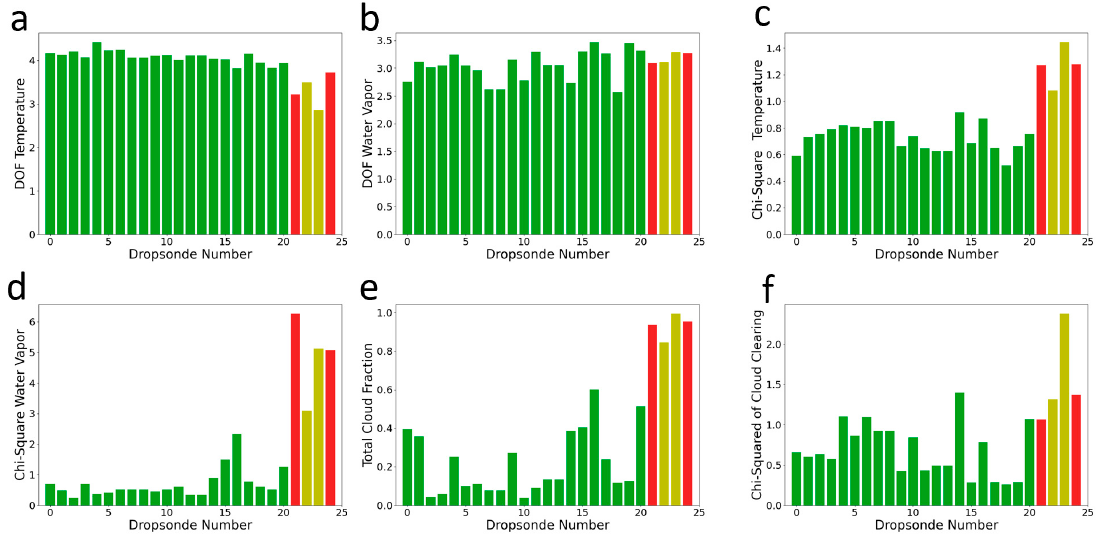
Figure 3. Select quality diagnostics for NUCAPS from NOAA-20 during the 18 September 2019 flight. The degrees of freedom (DOF) are shown for ( a ) temperature and ( b ) water vapor. The chi-squared residual errors are shown for ( c ) the temperature retrieval and ( d ) the water vapor retrieval. The cloud retrieval diagnostics are ( e ) the total cloud fraction and ( f ) the chi-squared residual error of cloud clearing. The bars are color coded by quality flag, as described in Figure 1.